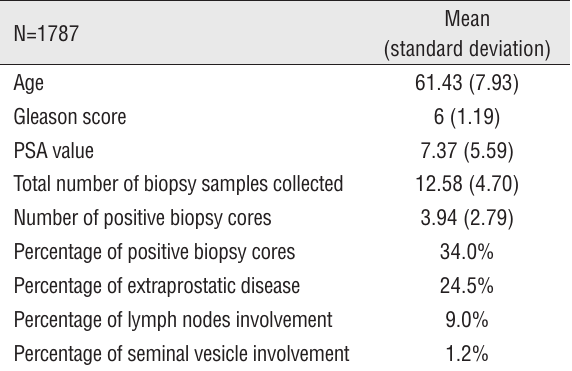
Table 1 - Clinical data of